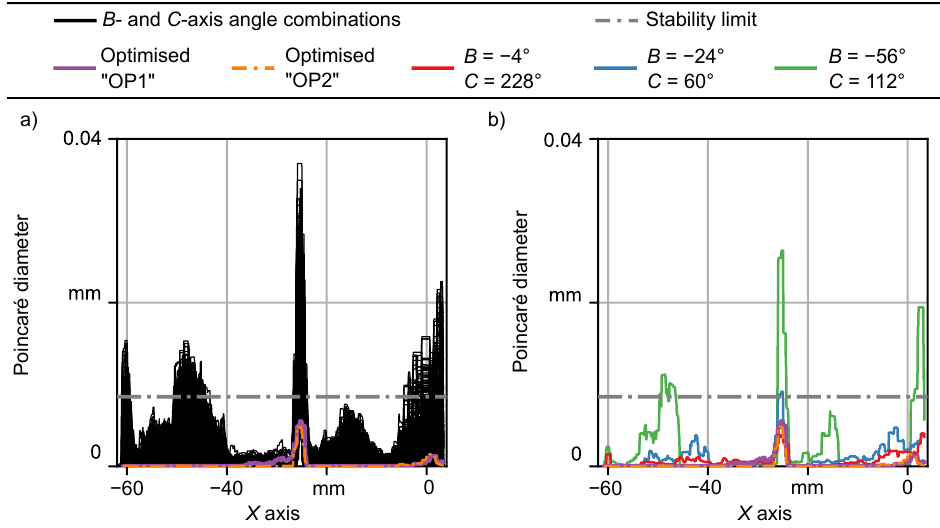
Figure 11. ( a ) PD plots for all analysed tool orientations and two optimised paths. ( b ) Mean PD plots of exemplary processes with constant tool orientations and the two processes with optimised tool